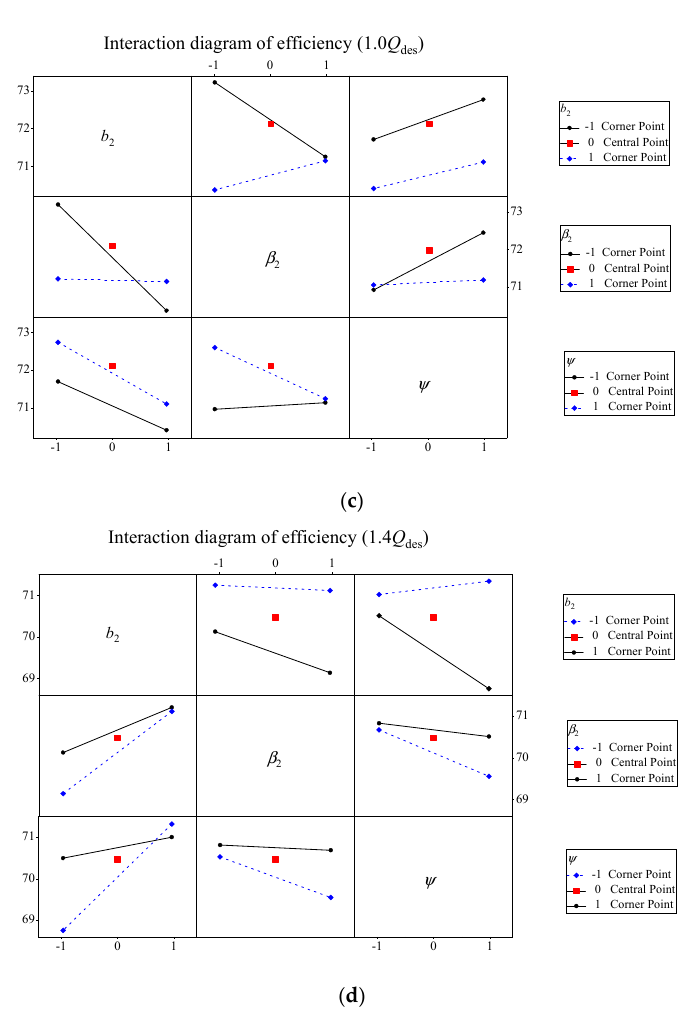
Figure 10. Interaction effect diagram of different flow rate point: ( a ) Interaction effect diagram of 0.6 Q des . ( b ) Interaction effect diagram of 0.8 Q des . ( c ) Interaction effect diagram of 1.0 Q des . ( d ) Interaction effect diagram of 1.4 Q des .